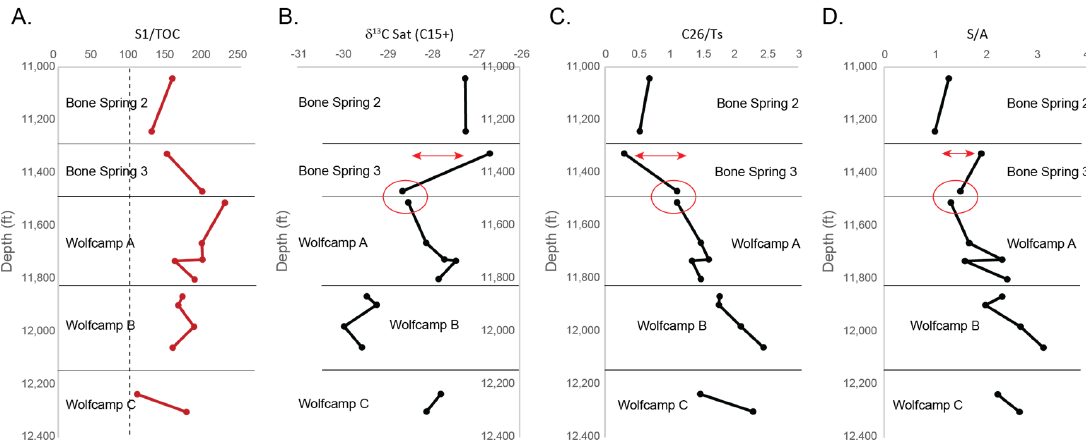
Figure 6. Depth cross ‐ plots for the 15 extracted hydrocarbon samples analyzed in the Delaware Basin case study. The depth range for the stratigraphic formations (Bone Spring 2, Bone Spring 3, Wolfcamp A, B and C) are highlighted. The red circles in the plots highlight samples with similar geochemical signatures across formations while the red arrows highlight distinct geochemical differences of sample extracts within formations. Detailed assessment of this information points towards some inter-formational (as well as intra-formational) migration and mixing, influencing the signatures preserved. ( A ) (S1 / TOC)*100 ratio calculated from Total Organic Carbon (Weight % TOC) and Pyrolysis data (S1 mg HC / g rock). ( B ) Carbon isotope signatures ( δ 13 C VPDB ) of the C15 + saturate fraction. ( C ) Upwelling biomarker ratio C26 S&R tricyclic terpane / C27 pentacyclic terpane Ts (18a, 21b-22,29,30-trisnorhopane) ratio (C26 / Ts). ( D ) Saturate Fraction relative to Aromatic fraction (C15 + ) ratio (S/A).